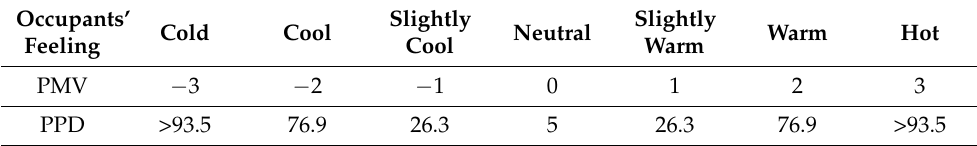
Table 1. Occupant comfort level based on PMV and PPD.